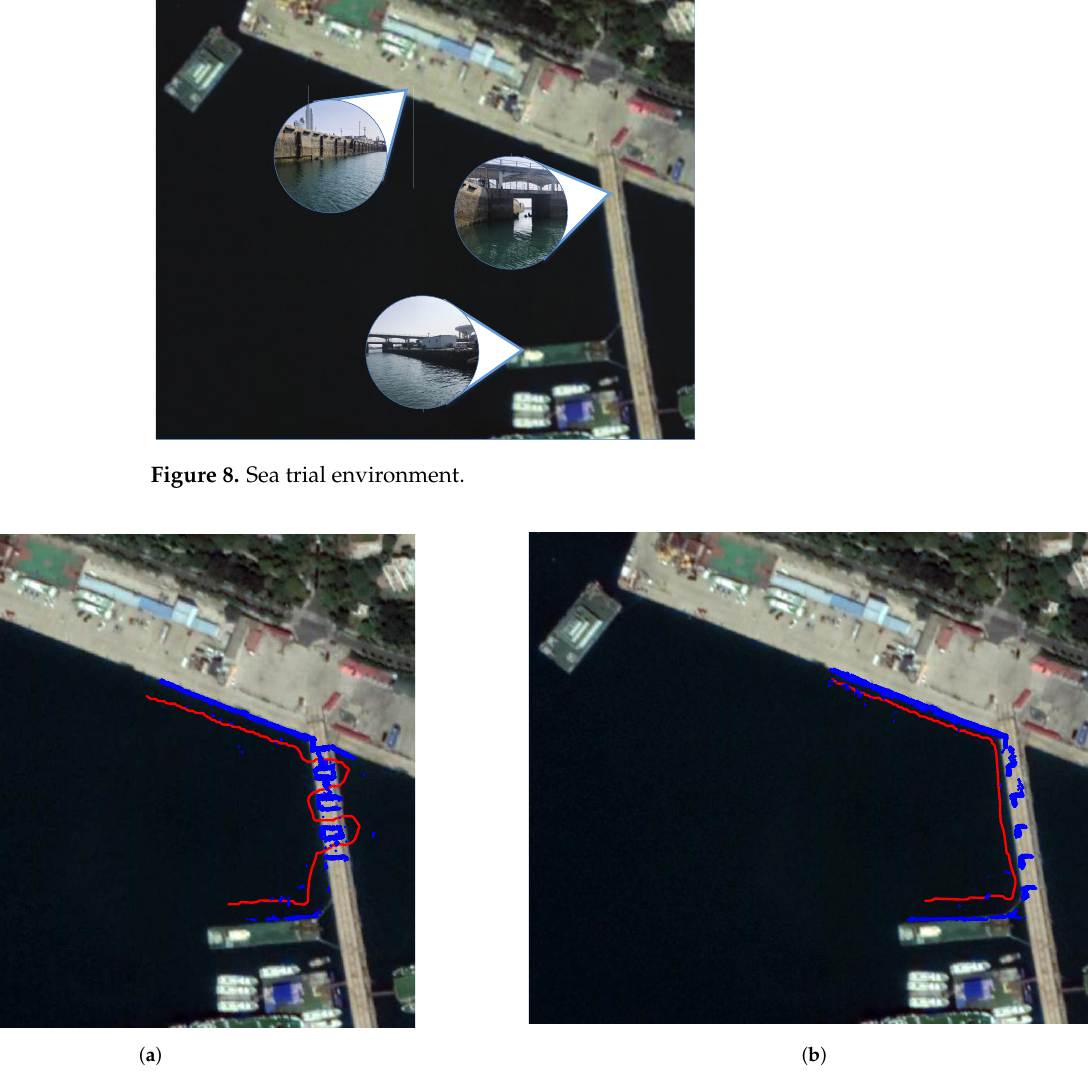
Figure 9. AUV real trajectory and sonar feature points. ( a ) AUV real trajectories and sonar feature points in Test 1. ( b ) AUV real trajectories and sonar feature points in Test